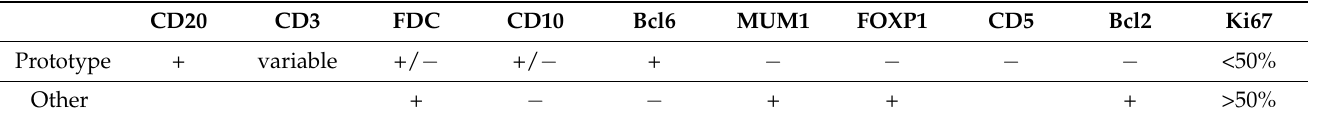
Table 3. Primary cutaneous follicle center lymphoma (PCFCL) immunohistochemistry